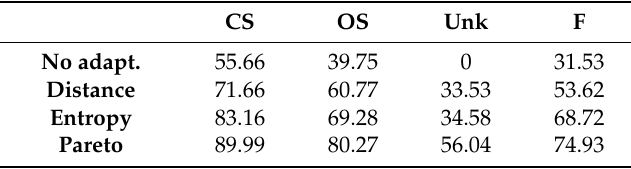
Table 7. Average performances obtained for the EHR